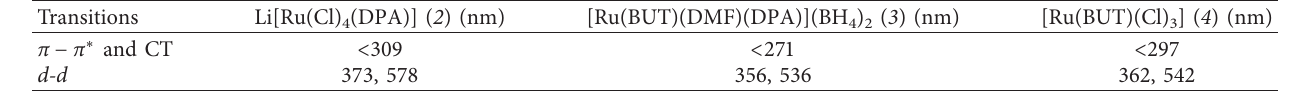
Table 2: Complexes and their associated electronic spectroscopy bands.